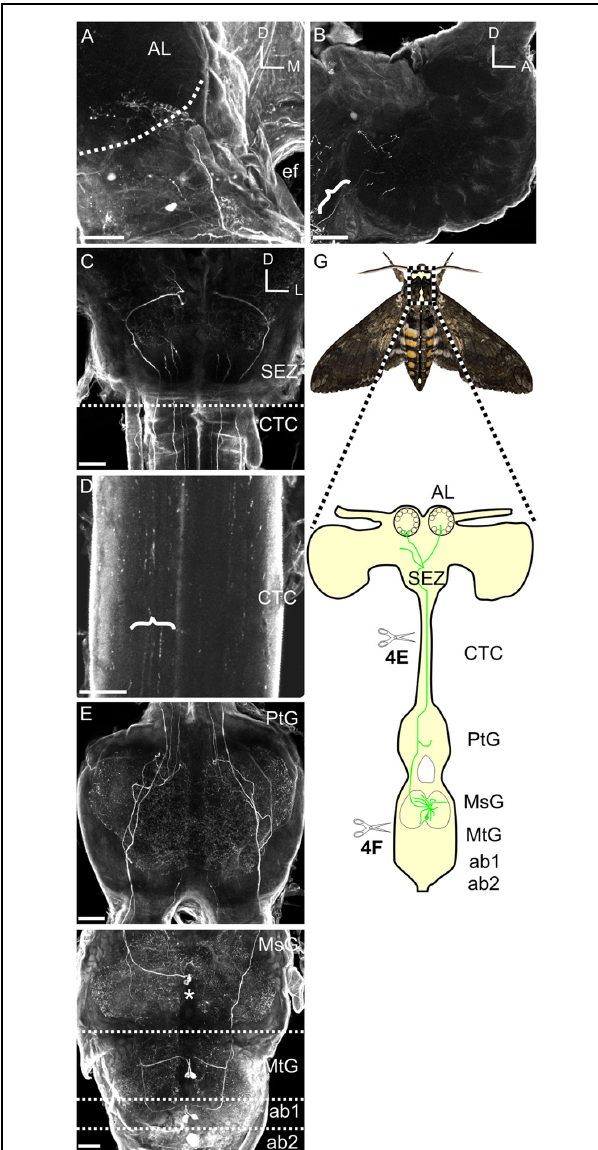
FIGURE 2 | Mesothoracic deutocerebrum histamine neurons project from the MsG to the AL of Manduca sexta . (A) Frontal view of HA-ir labeling in a whole mount brain preparation. Hatched line outlines the AL boundary. (B) Saggital view of a HA-ir process entering the AL (bracket). (C) Frontal view of HA-ir processes entering the SEZ from the cervicothoracic connective. Notice that four pairs enter the SEZ. (D) HA-ir processes in the cervicothoracic connective. Brackets highlight three HA-ir processes. (E) Horizontal view of the HA-ir processes in the prothoracic ganglion. Notice four pairs ascending from here as well. (F) Horizontonal view of HA-ir in the MsG, the metathoracic ganglion, and the first two abdominal ganglia. Each SEZment has a pair of HA-ir cell bodies located in the medial third of their respective ganglion. Asterisks highlights MDNn cell bodies. (G) Schematic of the Manduca nervous system highlighting the MDHns (green). Hatched boundary indicates the MsG. All scale bars = 100 μ m. AL, antennal lobe; ef, esophageal foramen; SEZ, subesophageal zone; CTC, cervicothoracic connective; PtG, prothoracic ganglion; MsG, mesothoracic ganglion; MtG, metathoracic ganglion; ab1, abdominal ganglion 1; ab2, abdominal ganglion 2.